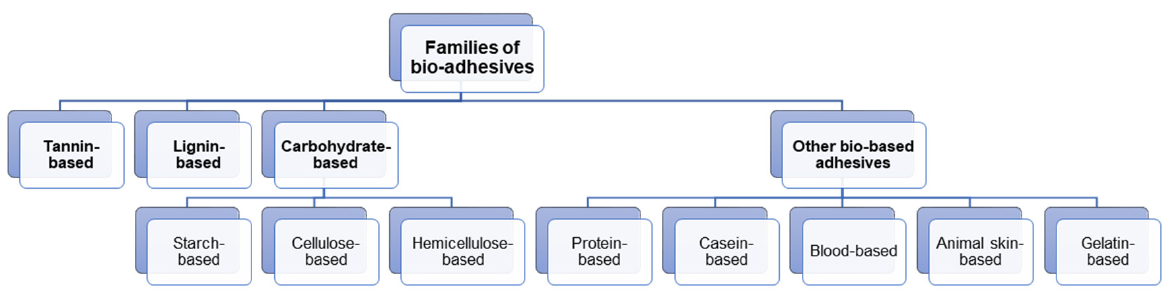
Figure 1. The most significant families of bio ‐ adhesives discussed in this